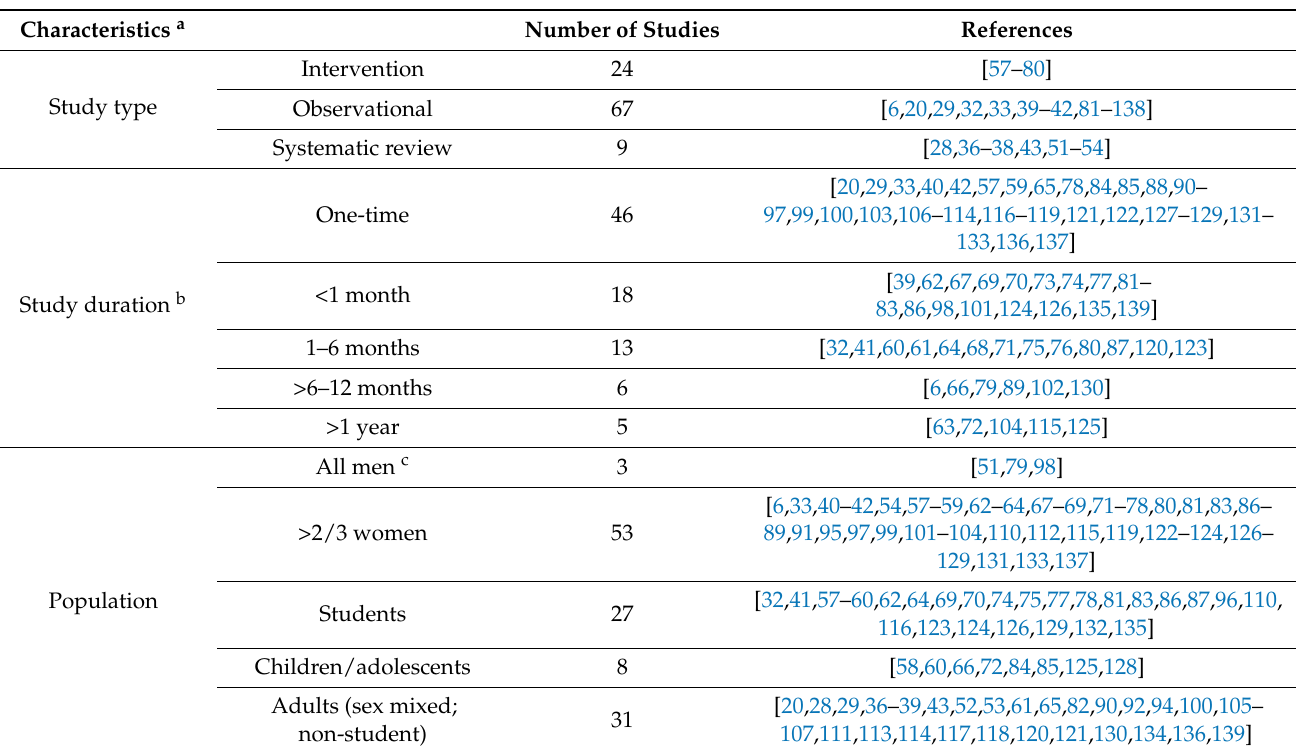
Table 1. Study characteristics ( n =